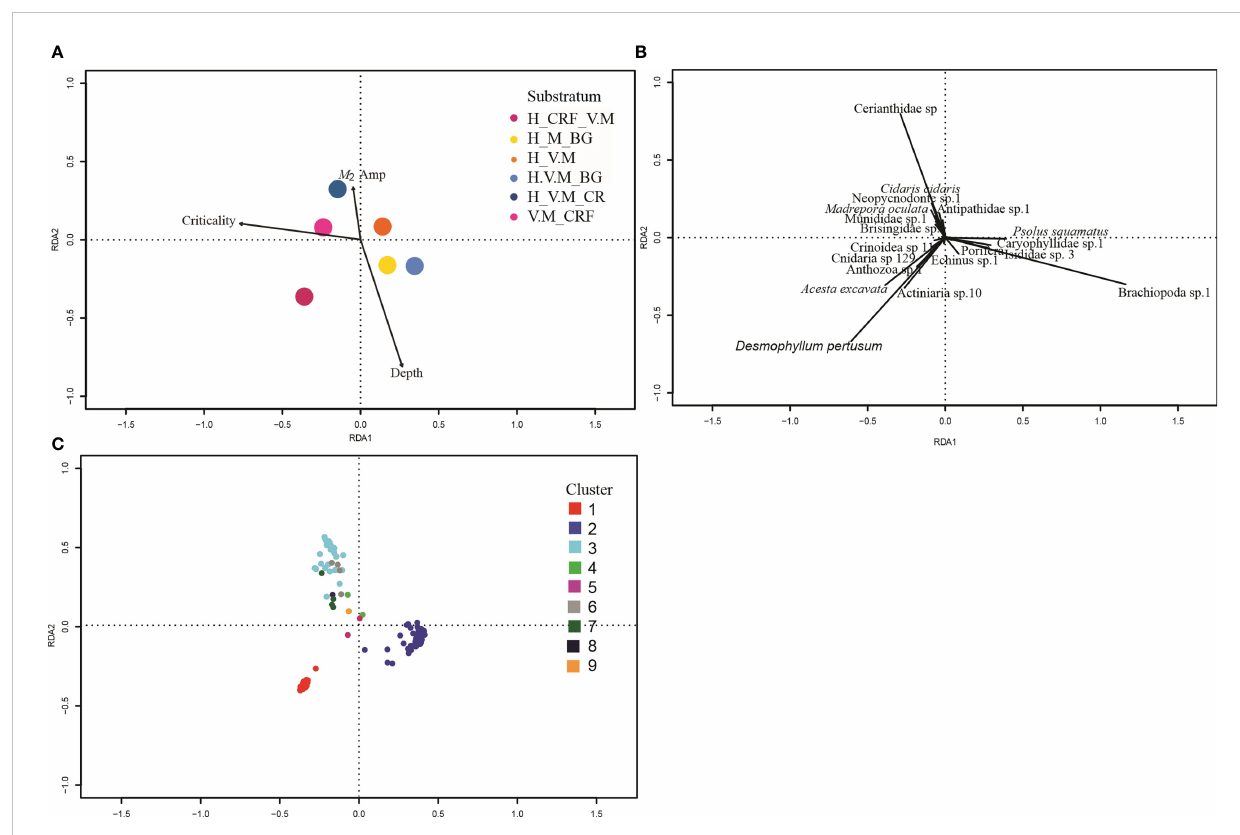
FIGURE 7 Canonical Redundancy Analysis of Hellinger transformed species data and selected environmental variables. For clarity, the triplot is displayed in three separate plots. (A) Environmental variables. The vector arrowheads represent high, the origin averages, and the tail (when extended through the origin) low values of the selected continuous environmental variables, centroids of categorical variables substratum shown as points colour coded by substratum type. (B) Species data with only species with strongest effect labelled. (C) Sites coloured by cluster following cluster analysis. Sites close to one another tend to have similar faunal structure than those further apart. Substratum codes: BG, Biogenic gravel; CR, Coral rubble; CRF, Coral reef framework; S, Sand; M, Mud; H, Hard; V, Veneer.